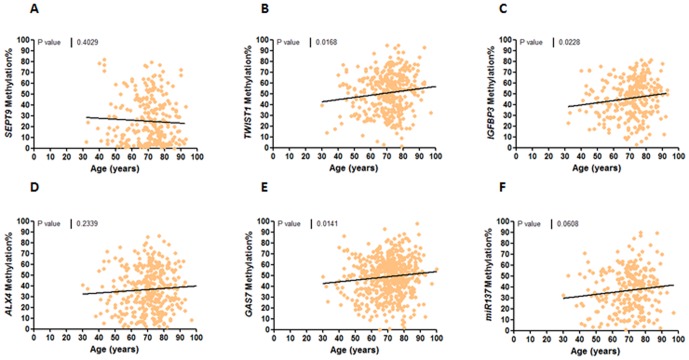
Correlation between primary tumor methylation and age of the crc patients. linear regression analysis comparing tumor methylation of sept9 (a), twist1 (b), igfbp3 (c), alx4 (d), gas7 (e) and mir137 (f) vs age of crc patients (years).